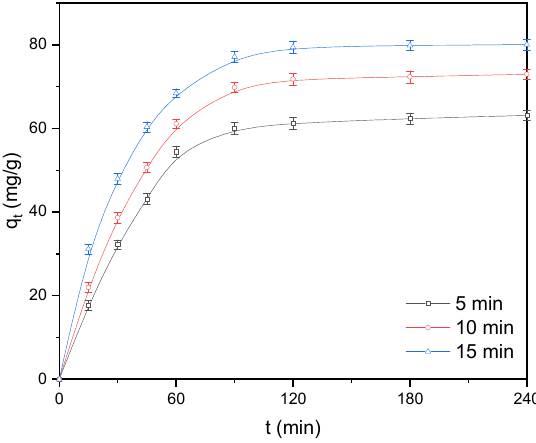
Figure 5. The e ff ect of pyrolysis time on adsorption of char. Figure 5. The effect of pyrolysis time on adsorption of char. Figure 5. The effect of pyrolysis time on adsorption of char.